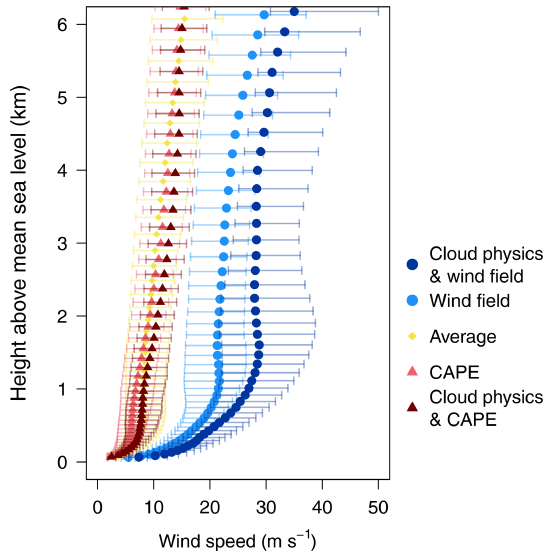
Figure 5. Clusterwise medians along with upper and lower quartiles of wind speed at each model level in ERA5 plotted at the mean model level height of the respective